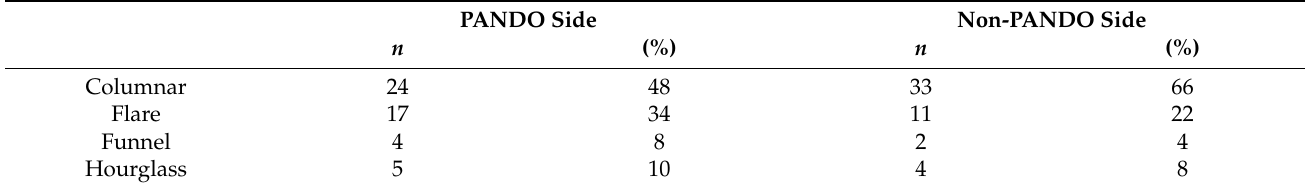
Table 4. Shape of the bony nasolacrimal